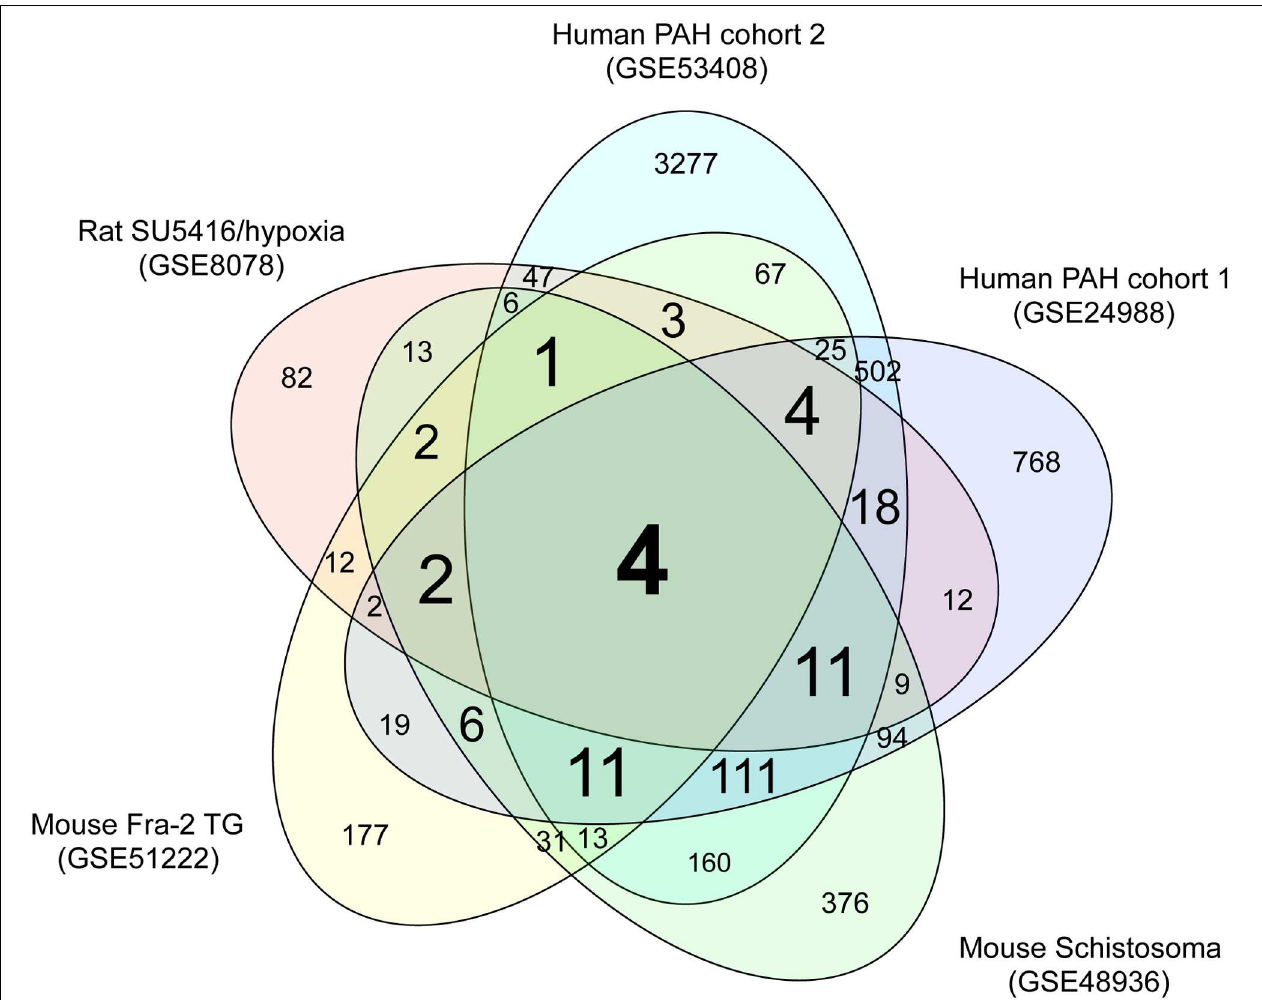
FIGURE 1 | Venn diagram of DEGs in the five PAH transcriptome datasets. Transcriptome data from a rat PAH model caused by treatment with the VEGFR inhibitor SU5416 and hypoxia (GSE8078); a mouse PAH model caused by overexpression of Fra-2, a causative gene for systemic sclerosis (GSE51222); a mouse PAH model caused by schistosomiasis (GSE48936); and two cohorts of human PAH patients (GSE24988 and GSE53408) were downloaded from a public database (GEO). Genes that were differentially expressed in the PAH and control groups of each dataset were identified as described in the methods. The numbers of DEGss unique to each transcriptome dataset and shared between datasets are